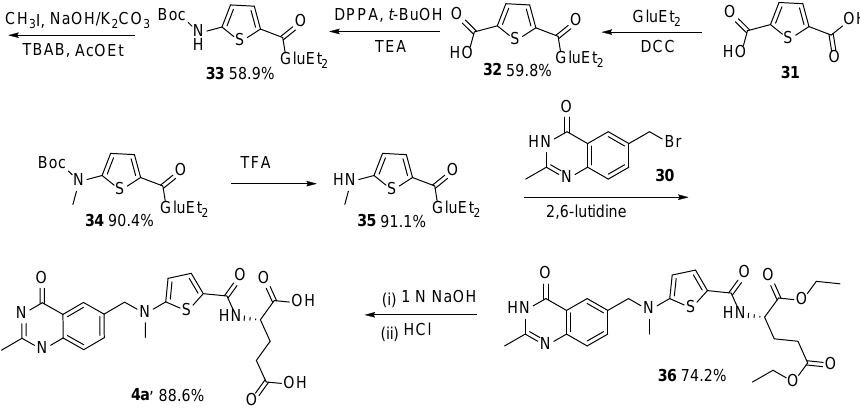
Scheme 16. Multistep synthesis of Raltitrexed starting from thiophene-2,5-dicarboxylic acid 31